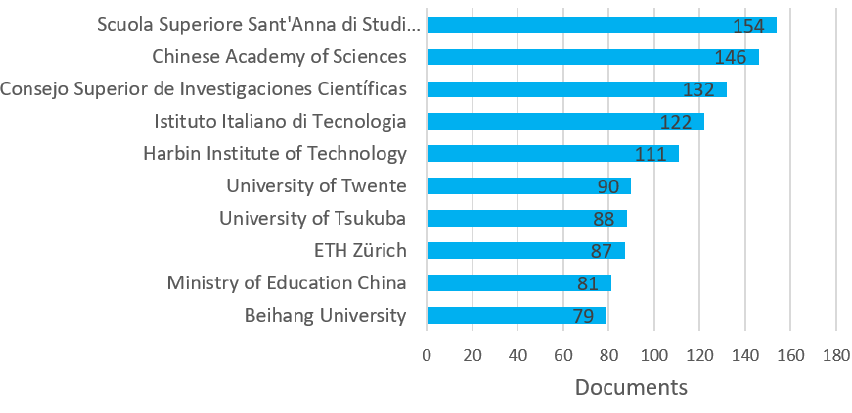
Figure 15. Graph of the top 10 institutions by number of publications referring to exoskeletons between 2010 and